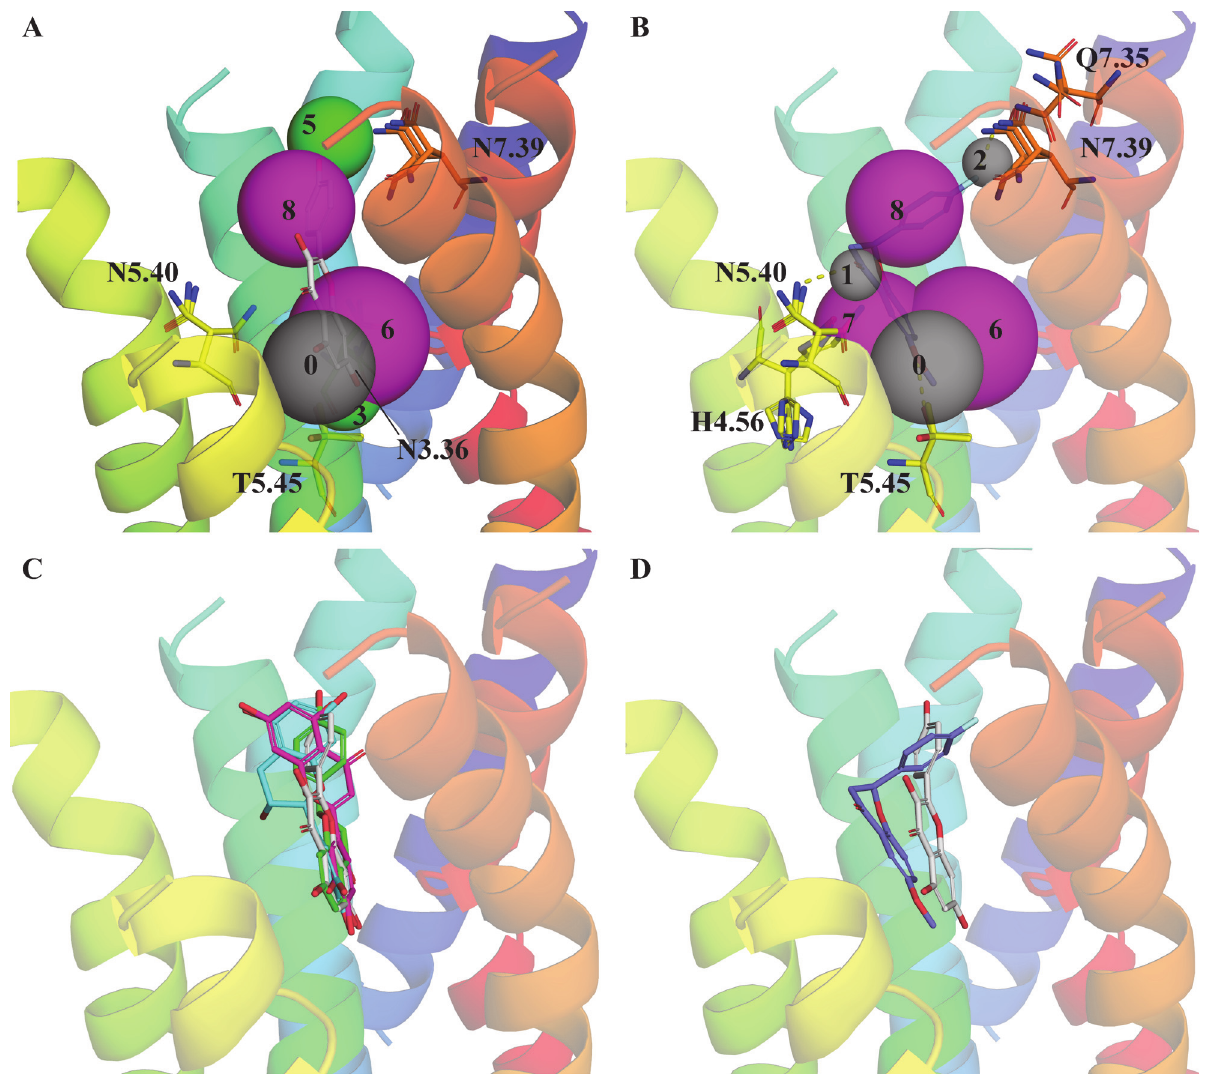
Fig 3. Selection of compounds fitted into the pharmacophore. A) Fitting of agonist kaempferol (gray) into the pharmacophore features 0 , 3 , 5 , 6 , 8 . Residues, which make hydrogen bonds to the agonist, are shown as sticks. B) Fitting of the blocker 4 ’ -fluoro-6-methoxyflavanone (S-enantiomer, blue) into the pharmacophore features 0 , 1 , 2 , 7 , 8 . Residues, which make hydrogen bonds (yellow dashes) to the blocker, are shown as sticks. C) Fitting of kaempferol (gray), luteolin (pink), naringenin (green), and epicatechin (cyan). D) Fitting of the kaempferol (gray) and 4 ’ -fluoro-6-methoxyflavanone (blue). The structures of 4 ’ -fluoro-6-methoxyflavanone, luteolin, naringenin, and epicatechin are shown in Fig. 4